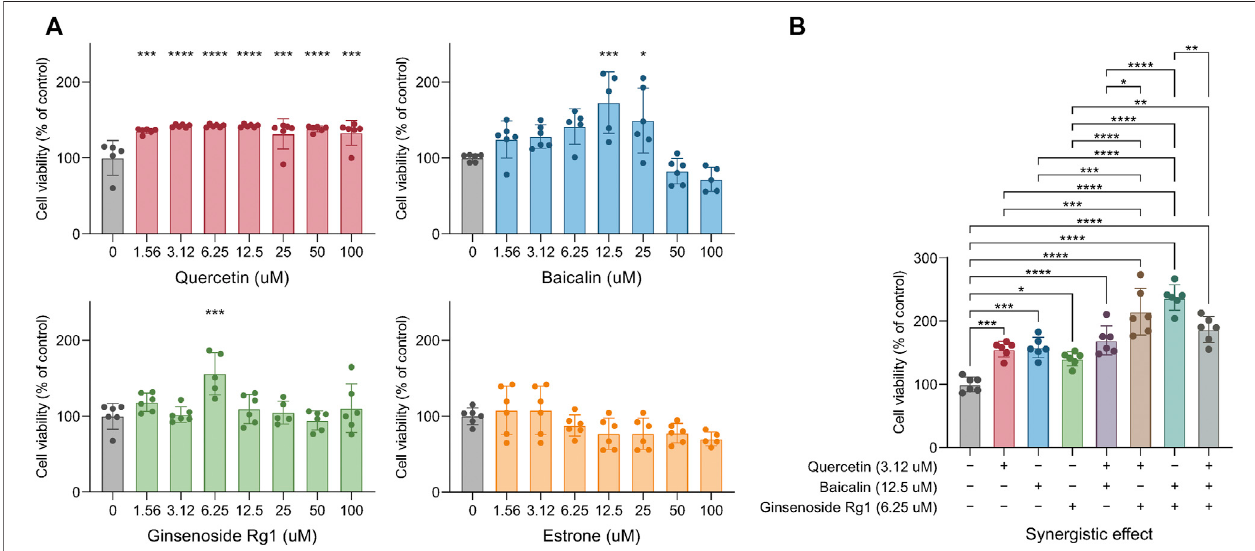
FIGURE 7 | Experimental veri fi cation of the compound synergistic effect: The effect of different concentrations of single drugs on cell viability (A) . The synergistic effect of three drugs on cell activity (B) . Signi fi cance: * p < 0.05, ** p < 0.01, *** p < 0.001, and **** p < 0.0001.